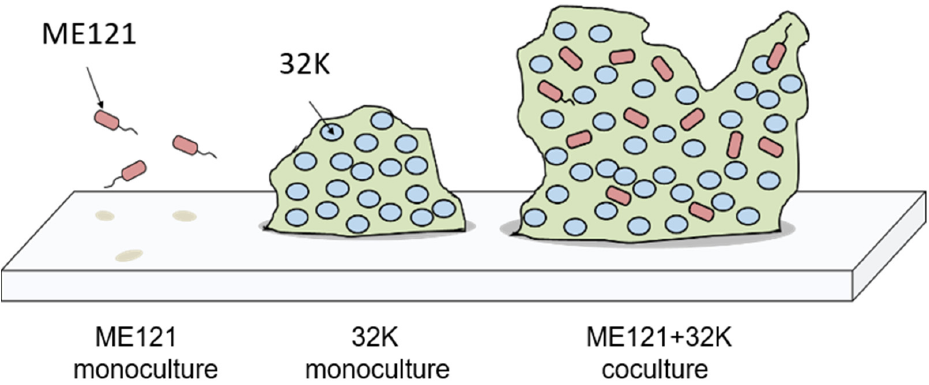
Figure 8. Schematic representation of biofilm formation of strains ME121 and 32K. In the synthetic medium used in this experiment, strain ME121 does not form a biofilm when cultured alone, whereas monoculture of strain 32K forms a biofilm. It was speculated that a larger biofilm was formed in the coculture of strains ME121 and 32K.